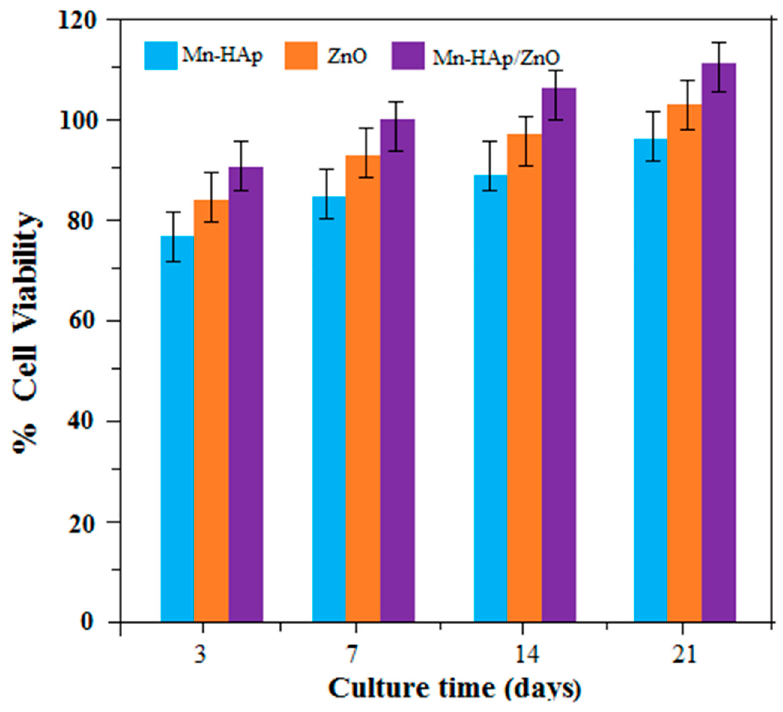
Figure 11. Cell viability of Mn-HAp, ZnO, and Mn-HAp/ZnO bilayer coating on 316L SS.